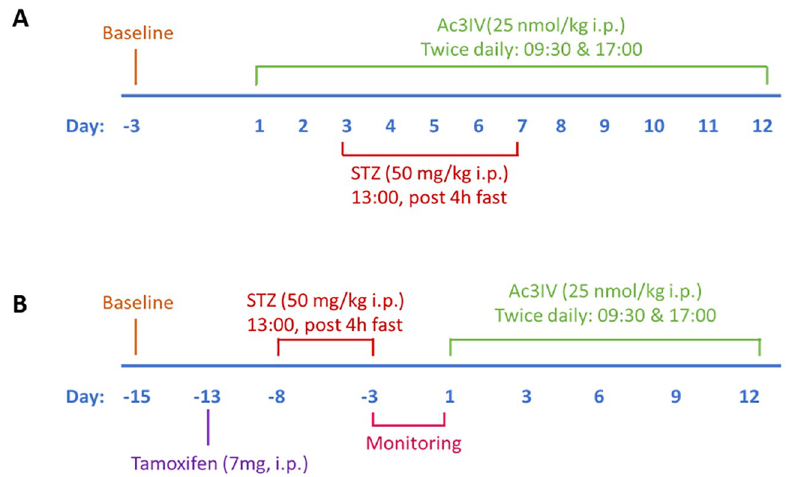
Fig 1. Experimental timeline for Ins1Cre /+ Rosa26-eYFP and Glu CreERT2 ; Rosa26-eYFP transgenic mouse studies. (A) Ins1 Cre/+ ; Rosa26-eYFP mice (n = 6) received twice daily treatment with saline vehicle (0.9% NaCl) or Ac3IV (25 nmol/kg bw, i.p.) 3 days prior to induction of insulin-deficient diabetes by STZ. (B) The ability of twice daily treatment with Ac3IV (25 nmol/kg bw, i.p.) to reverse beta-cell loss in STZ-induced diabetes was examined in Glu CreERT2 ; Rosa26-eYFP mice (n =